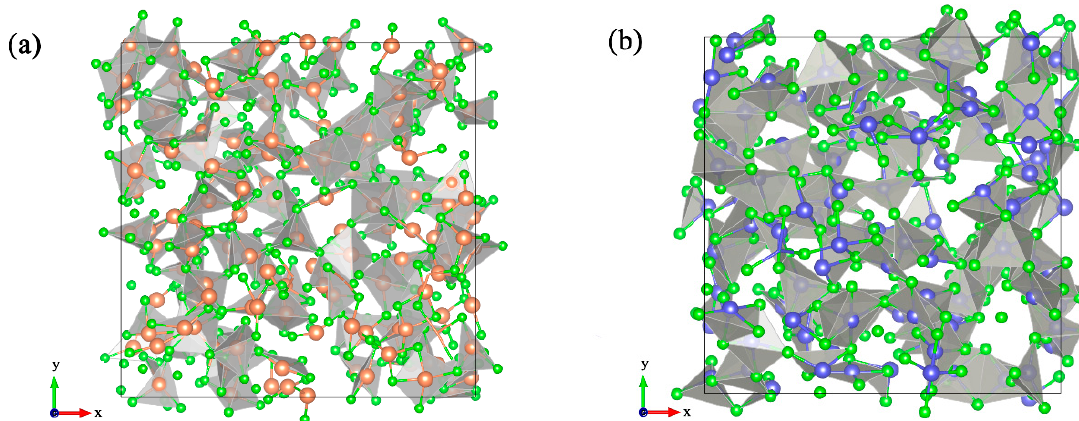
Figure 4. Snapshots of ion local structures in molten chloride salts: ( a ) MgCl 2 at 1000 K, Mg 2+ in orange, Cl − in green; ( b ) ZnCl 2 at 600 K, Zn 2+ in blue, Cl − in green.